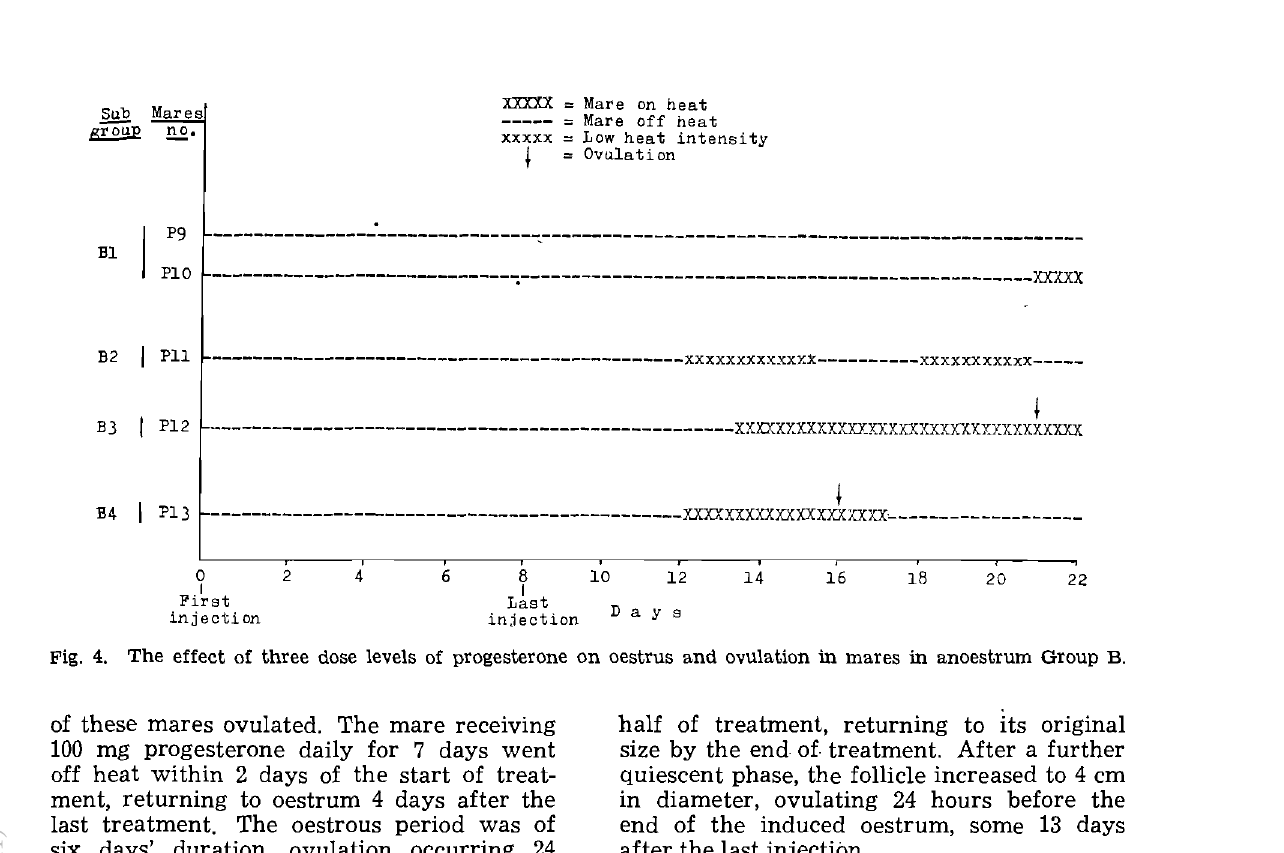
Fig. 4. The effect of three dose levels of progesterone on oestrus and ovulation in mares in anoestrum Group B. of these mares ovulated. The mare receiving 100 mg progesterone daily for 7 days went off heat within 2 days of the start of treat ment, returning to oestrum 4 days after the last treatment. The oestrous period was of six days' duration, ovulation occurring 24 hours before the end of this phase. The mare was served and